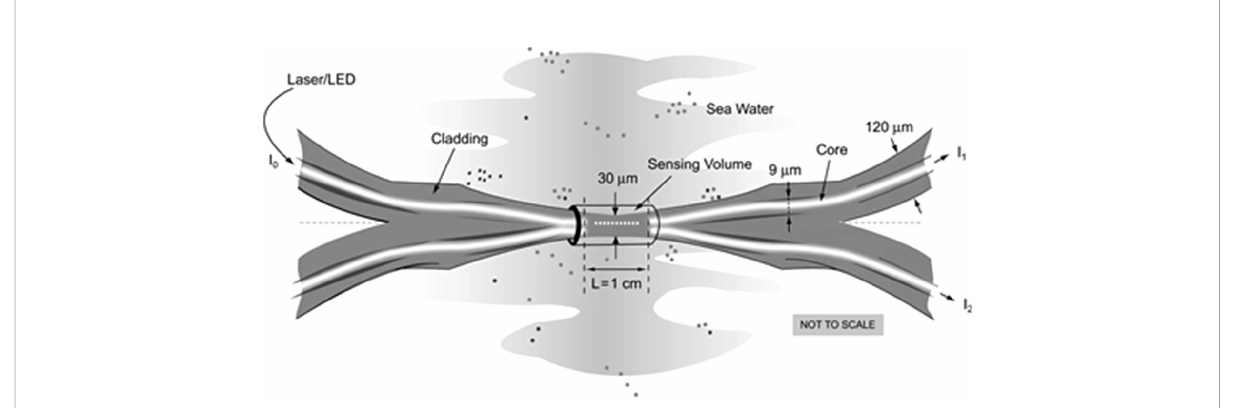
FIGURE 8 Schematic of the fused fi bers with the cladding removed in the sensing area from Alford et al., 2006. The input intensity I 0 and the output intensities I 1 and I 2 are